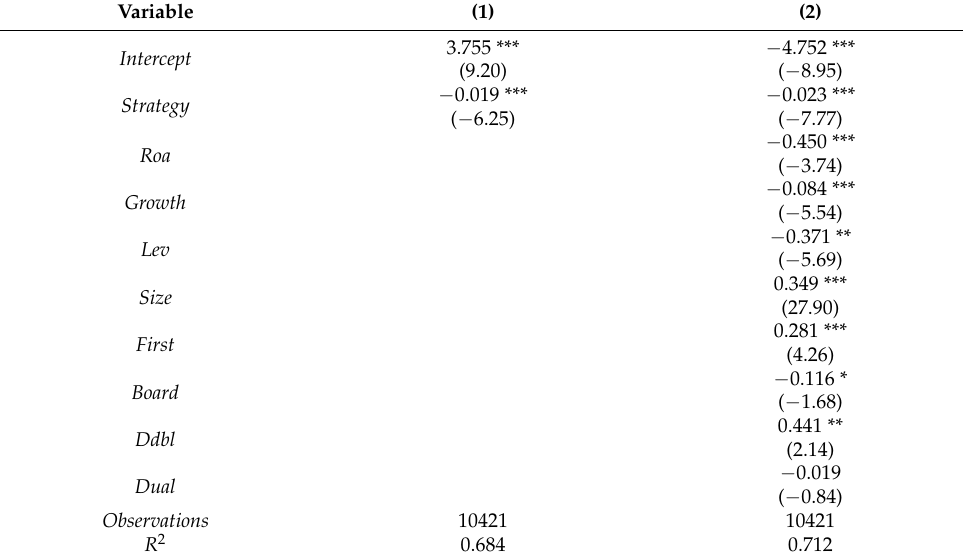
Table 10. Business strategy and environmental information disclosure quality: Panel